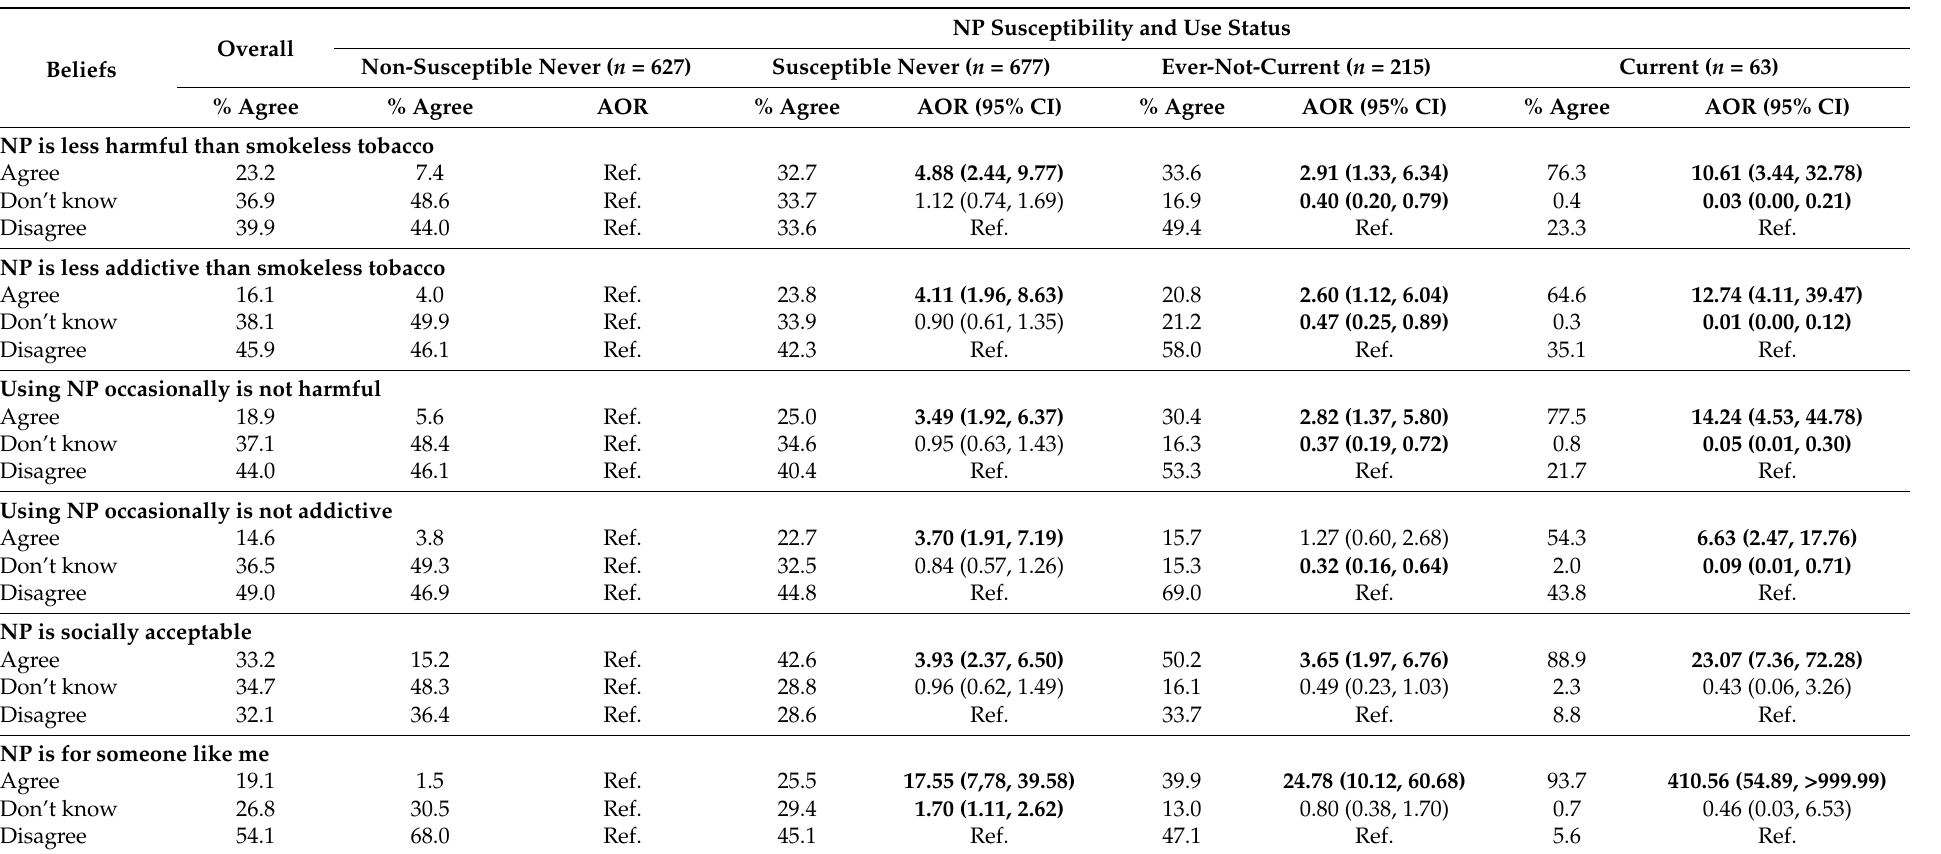
Table 2. Weighted prevalence of NP-related beliefs and their associations with nicotine pouch susceptibility and use status, 2021 (N = 1582).